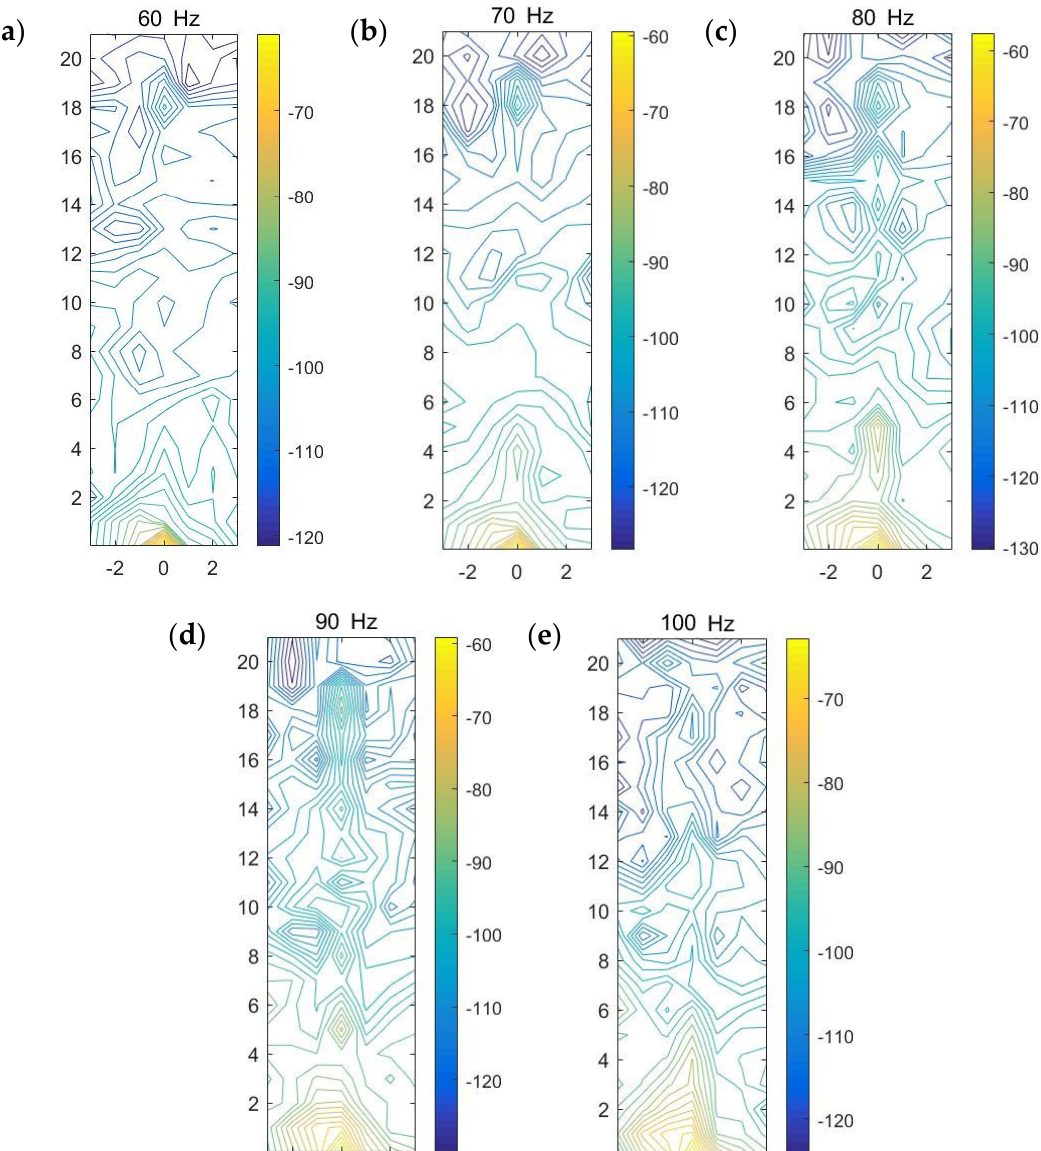
Figure A1. Grid of measurement points in [20].